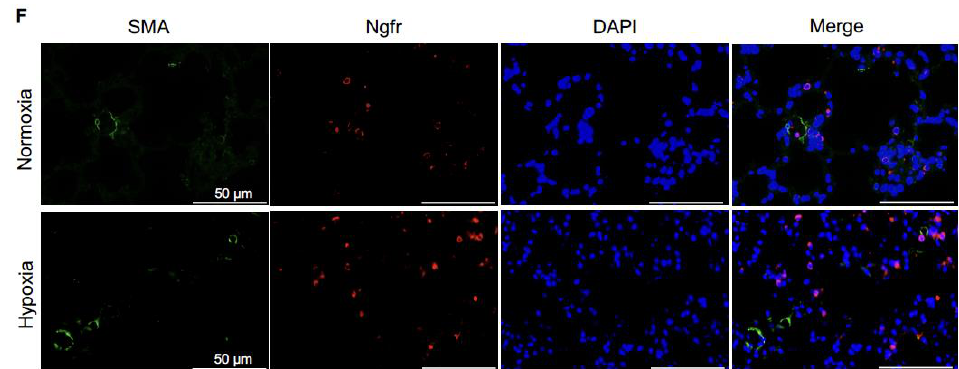
Figure 1. Increase in frequency of Ngfr-positive cells in WT mice under hypoxic conditions. FCM was performed to assess the frequency of Ngfr-positive cells in PBMCs of WT mice under normoxic and hypoxic conditions. Representative flow cytometric figures (mononuclear cells ( A ), single cells ( B ), and Ngfr-positive cells ( C )). ( D ) The frequencies of Ngfr-positive cells in PBMCs (% Ngfr) of WT mice under normoxic and hypoxic conditions. ( E ) Ngfr expression in mouse lung in response to hypoxia. ( F ) Immunofluorescence for Ngfr in lung under normoxic and hypoxic conditions. ( G ) Immunostaining for Ngfr in lung under normoxic and hypoxic conditions. Red arrows show Ngfr-positive cells. FCM, flow cytometry; SSC, side scatter; FSC, forward scatter; Ngfr, nerve growth factor receptor; PBMC, peripheral blood mononuclear cell; WT, wild type. Center lines show the medians, box limits indicate the 25th and 75th percentiles, whiskers extend 1.5 × the interquartile range from the 25th and 75th percentiles. ** p < 0.01 versus WT Normoxia.